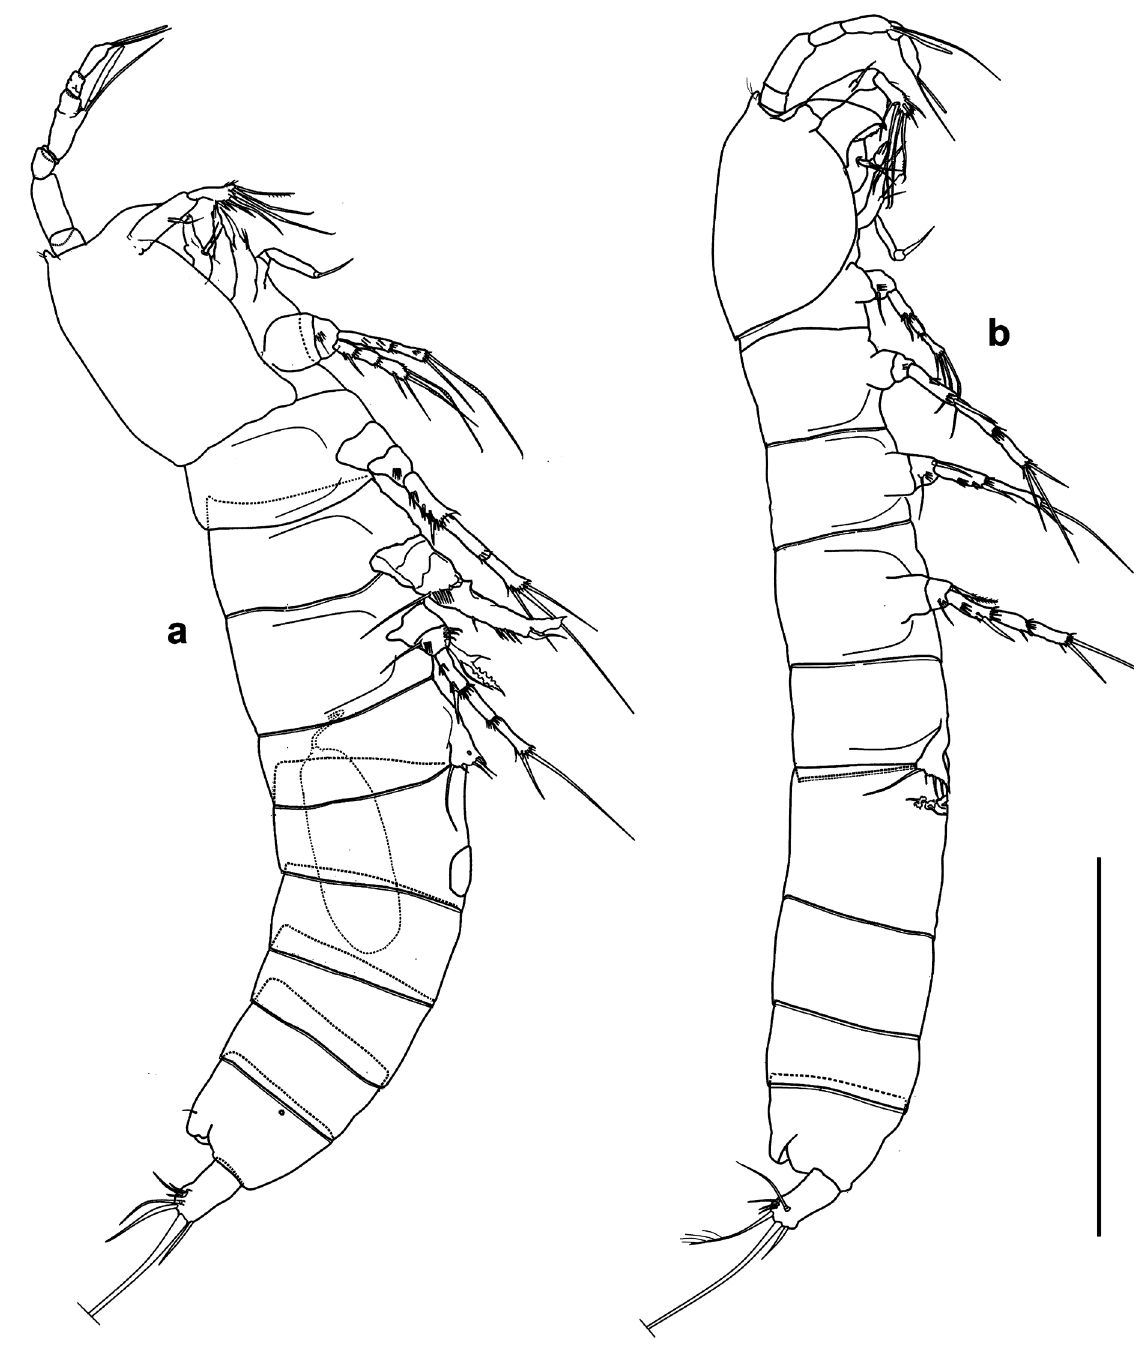
Fig. 2. Cottarellicaris sanctiangeli Bruno & Cottarelli sp. nov. from Grotta superiore di Sant’Angelo (NHMUK). a . ♂, habitus. b . ♀, habitus. Scale bar: 50